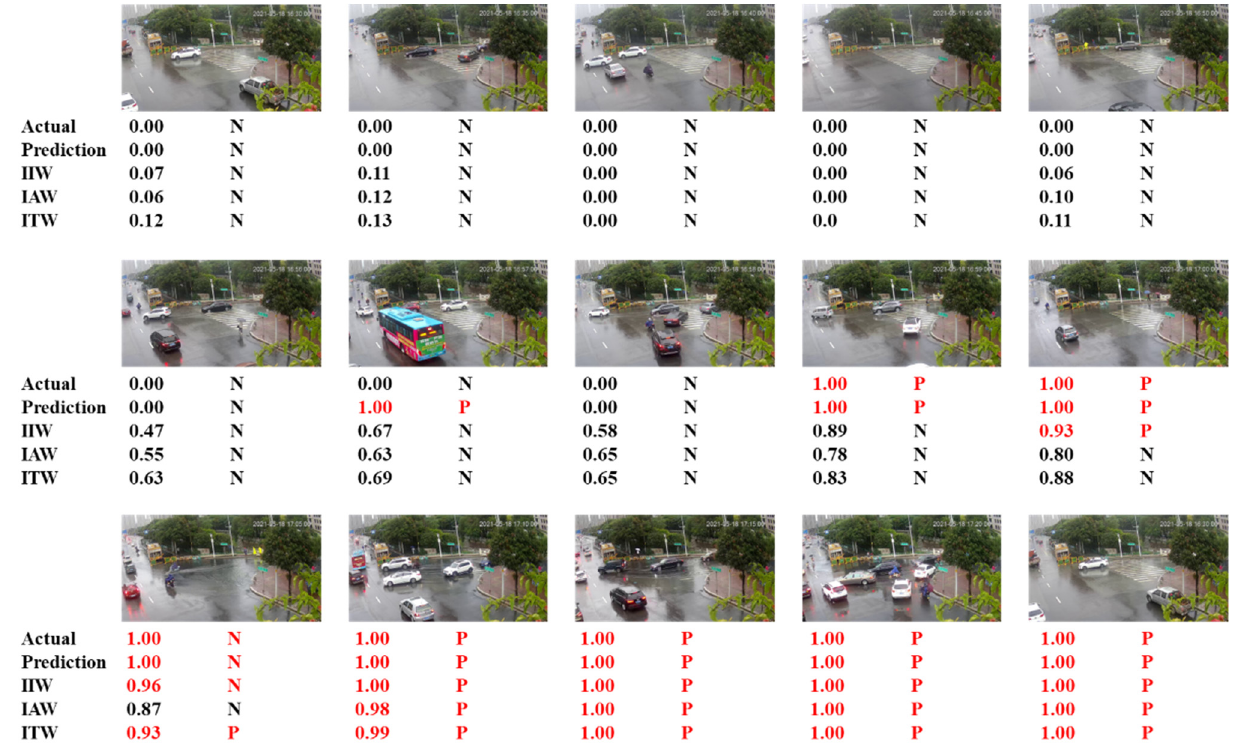
Figure 14. Waterlogging images in real scenes. P denotes a positive result and N denotes a negative result.